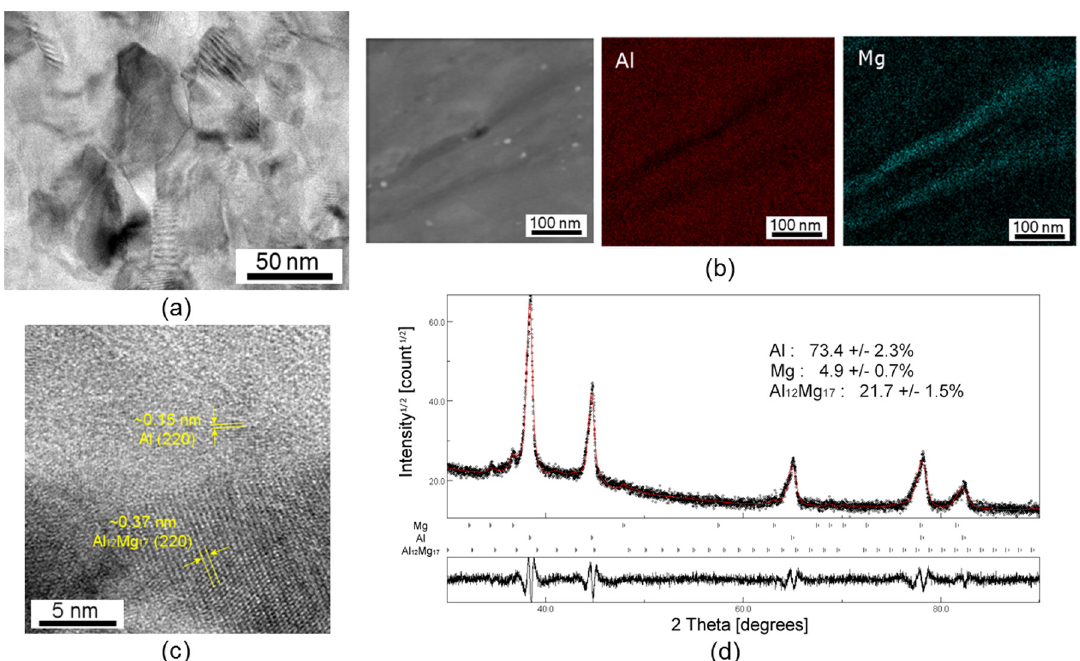
Figure 3. TEM micrographs with (a) a bright-field image, (b) a dark-field image and the corresponding compositional maps of Al and Mg and (c) a high resolution image and (d) the XRD pattern in black and the simulated line profile in red for the edge of the Al-Mg system after HPT for 10 turns.